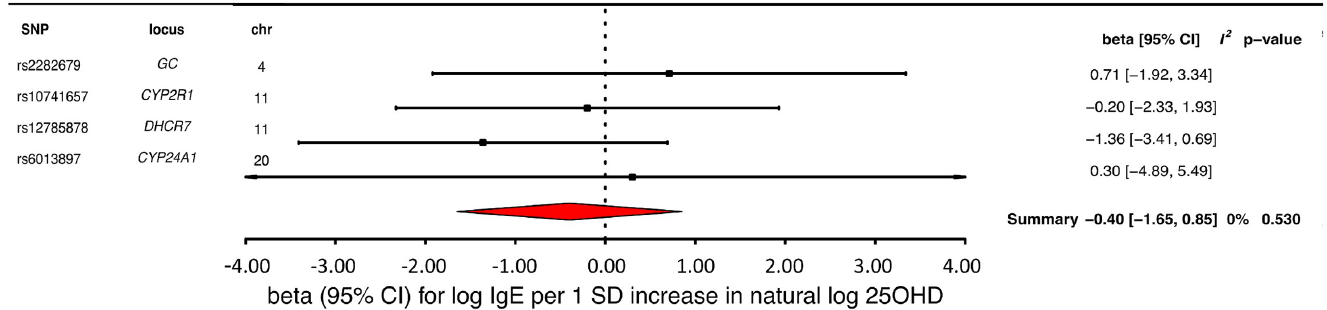
Fig 6. Mendelian randomization estimateof the association of 25-hydroxyvitamin D (25OHD) levels with Immunoglobulin E (IgE) levels. Estimates obtainedfrom using a fixed-effects model. 95% CI, 95% confidenceinterval; chr, chromosome,OR, odds ratio; SD, standarddeviation;SNP, single-nucleotide